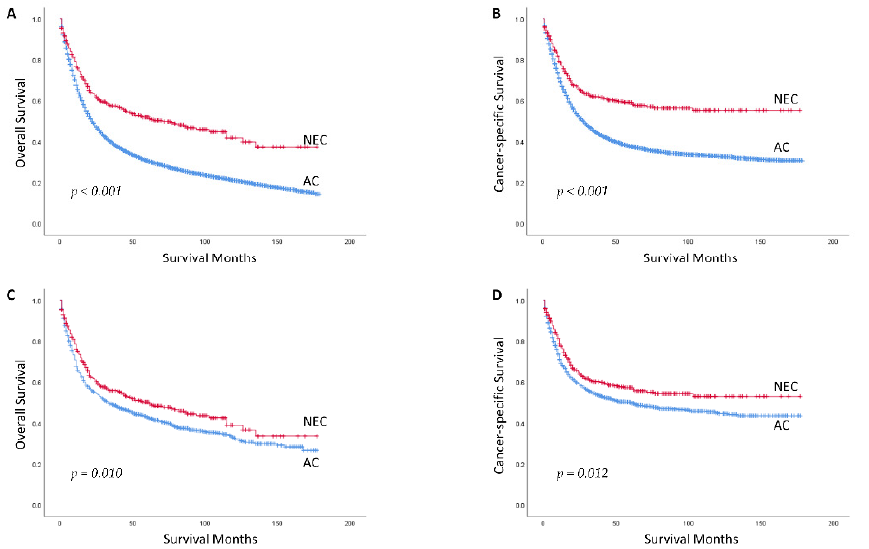
Figure 1. Kaplan–Meier Survival Curves for White Patients with Gastric Neuroendocrine Carcinoma and Adenocarcinoma before (( A ): OS; ( B ): CSS) and after PSM (( C ): OS; ( D ): CSS). NEC: Neuroen- docrine Carcinoma; AC: Adenocarcinoma; PSM: Propensity Score Matching; OS: Overall Survival; CSS: Cancer-specific Survival. Table 1. Baseline Clinicopathologic Characteristics of White Patients with Gastric Neuroendocrine Carcinoma and Adenocarcinoma in the Unmatched Data. No. (%)